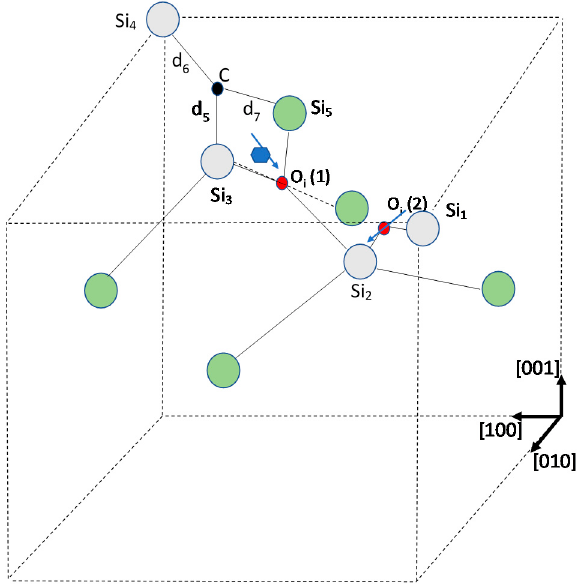
Figure 5. The C i O 2i configuration. The blue hexagon corresponds to the reduced mass μ , of the C–O(1) dipole. Blue arrows indicate the oscillation directions of the C–O(1) and the O(2) dipoles.